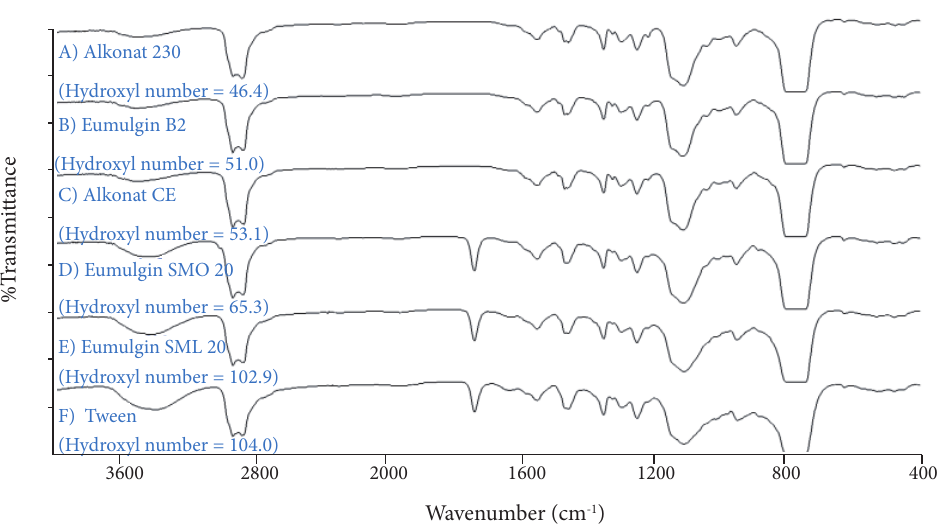
Figure 1. Fourier transform medium infrared transmission spectra of surfactant samples (Hydroxyl number in mg KOH/g, measured